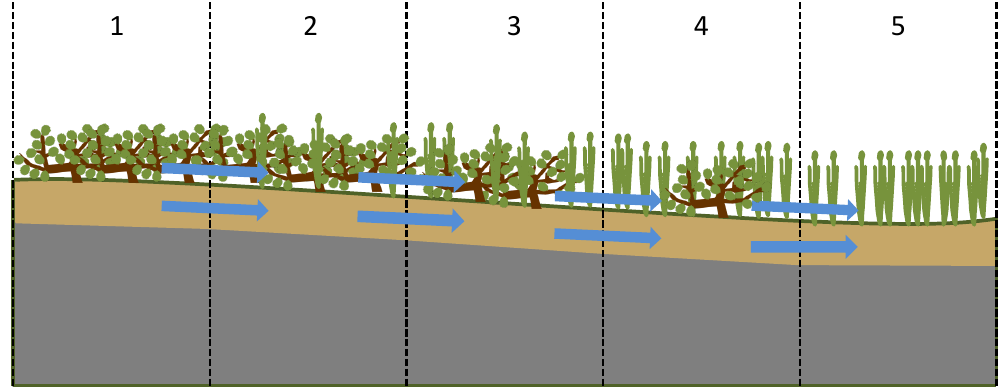
Figure 2. Vegetation types used in simulations of NUCOM-tundra. The vegetation types represent landscape positions, ranging from rela- tively dry shrub-dominated (1) to wet graminoid-dominated (5) vegetation. Blue arrows indicate water